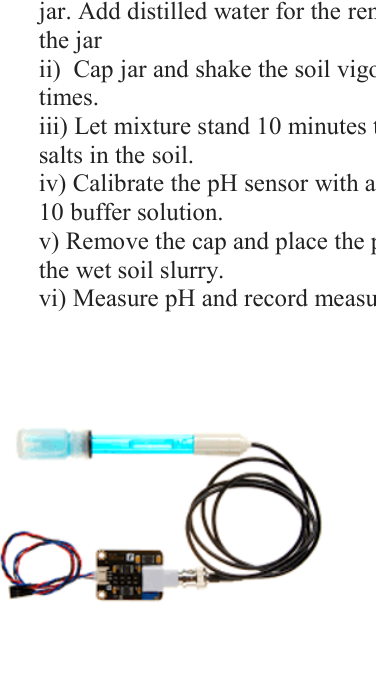
Fig.9 pH sensor connected with LCD